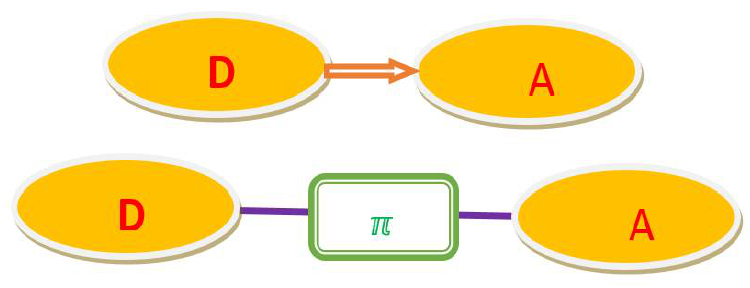
Figure 1. Donor–acceptor (DA) model system diagram.